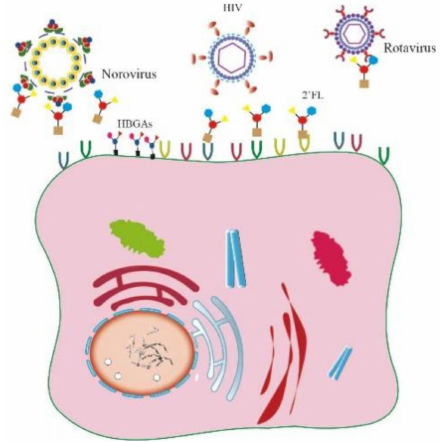
Figure 7. Schematic overview on the antiviral role of 2’-FL. Similar to cell surface glycan (such as HBGA), 2’-FL can act as a soluble decoy receptor to bind to the virus to block infection; 2’-FL can also block viral attachment by binding to cell surface